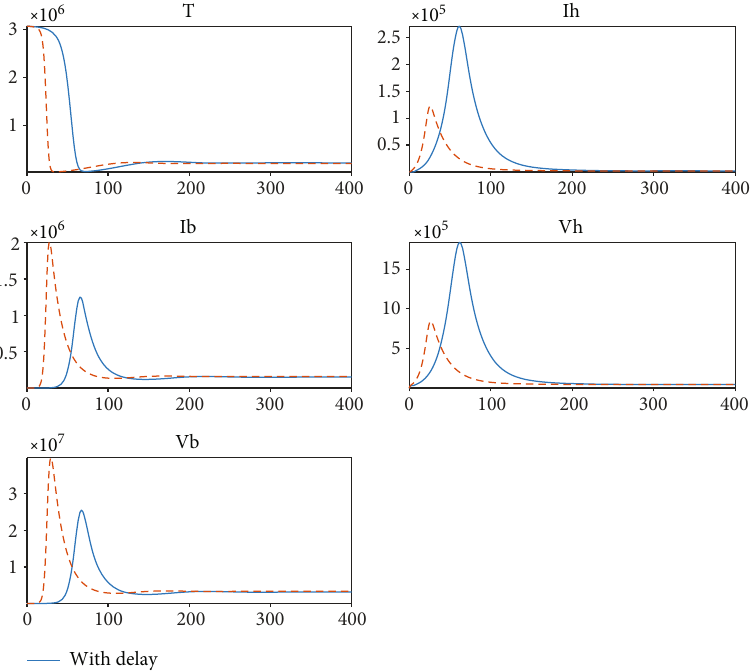
Figure 2: Dynamics of delayed system (1) with the delay parameter as τ axes represent time in